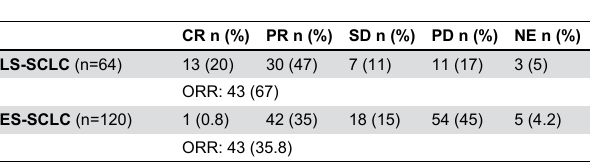
Table 2. Response to